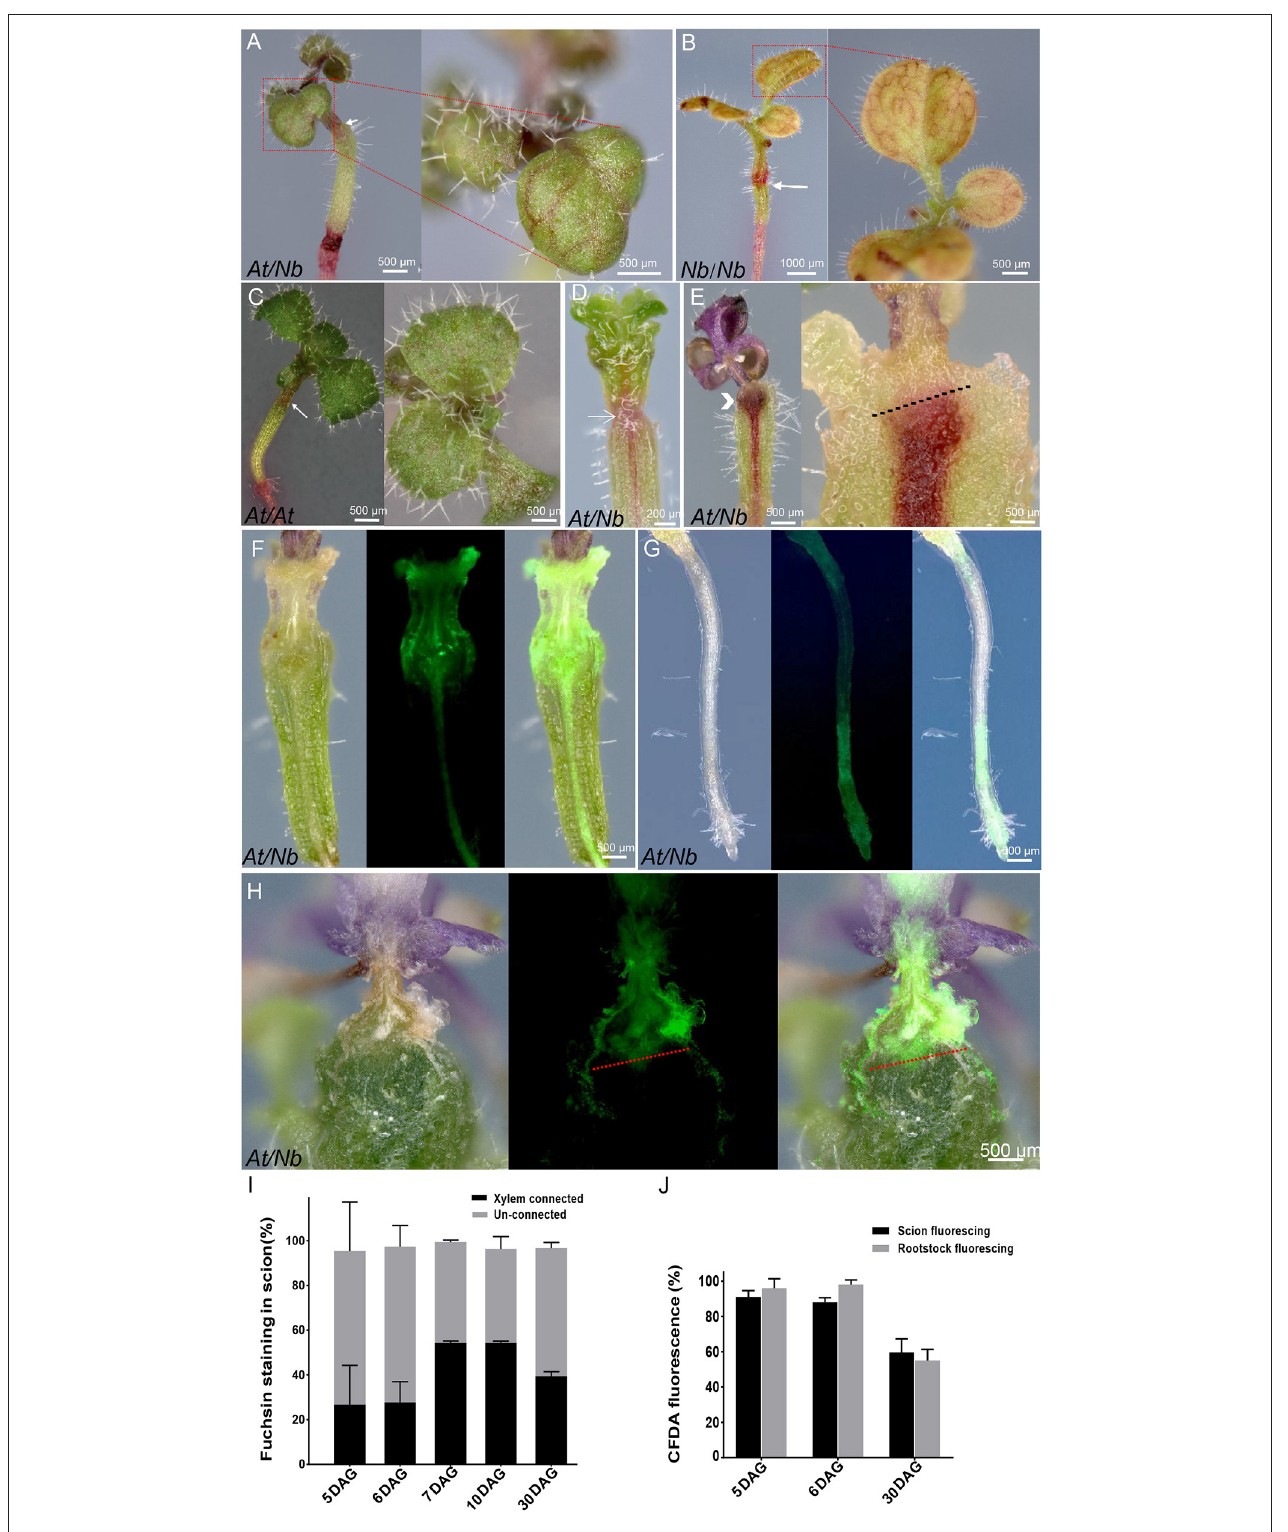
FIGURE 2 | Apoplastic and symplastic dye loading in At / Nb grafts/ (A–E) 1% acid fuchsin loading. (A) Fuchsin staining in the veins of 10-DAG group A plants. (B) 7 DAG of Nb self-graft. (C) 7 DAG of At self-graft. (D) 5-DAG At / Nb plants (group A). (E) 30 DAG of a quiescent graft (group C). Chevron indicated the accumulated fuchsin in the graft union of retarded grafts. An arrow indicated the graft union. The black dotted line indicated where the fuchsin stops. (F–H) CFDA loading in the